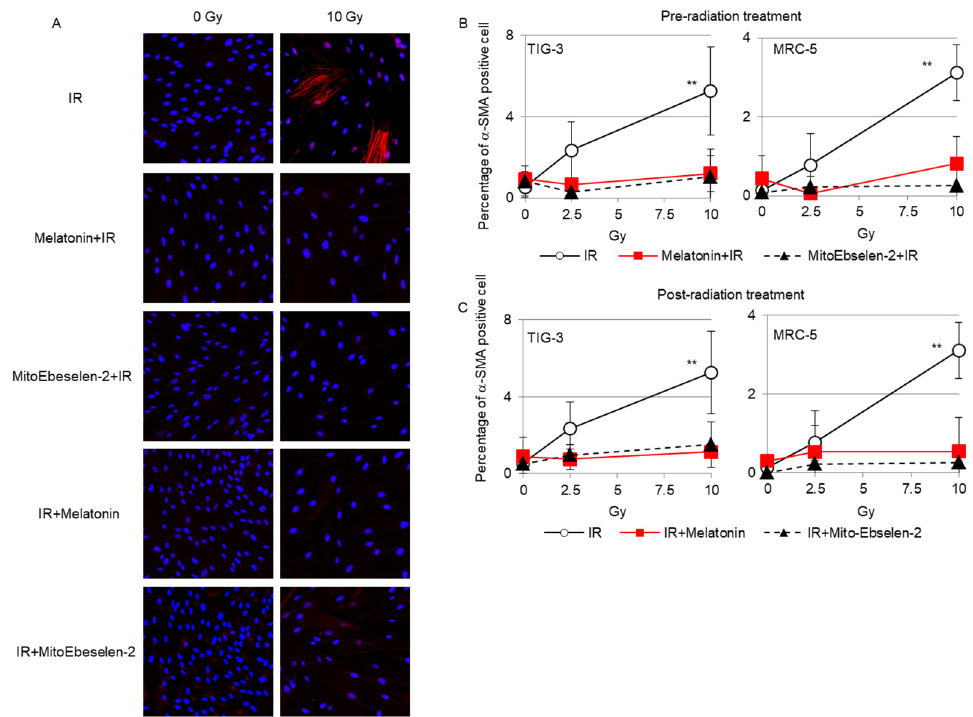
Figure 5. Induction of α -SMA-staining cells ( A ) α -SMA staining (red) was observed in irradiated TIG-3 cells. The ratio of α -SMA staining cells treated melatonin or MitoEbeselen-2 at pre-radiation ( B ) or post-radiation ( C ) is shown in the graph. Asterisk indicates a significant difference in the ratio of α -SMA-staining cells compared with that of non-irradiated control cells.